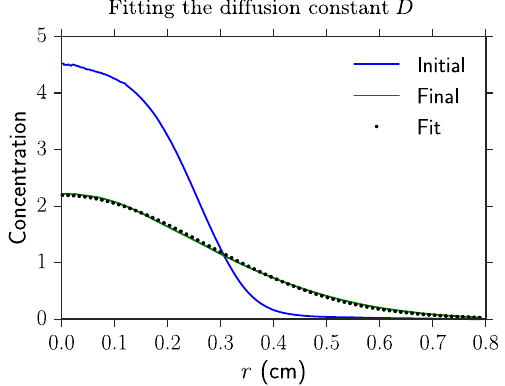
FIG. 15. Simulated average flow velocity as a function of mass ac 1 into a submerged yeast colony in rich flux rate j colony ¼ nutrient conditions. The velocity field is determined above the center of the colony in the rising plume of fluid from the bottom to the top of the